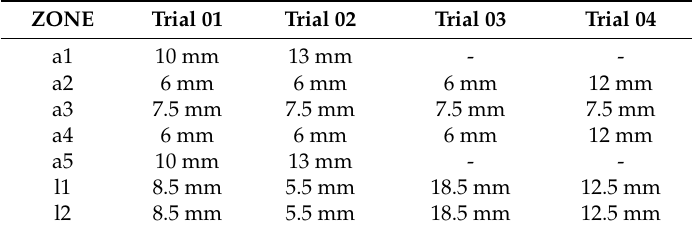
Table 2. Distances between fixtures placed in the mandible and cantilever lengths.